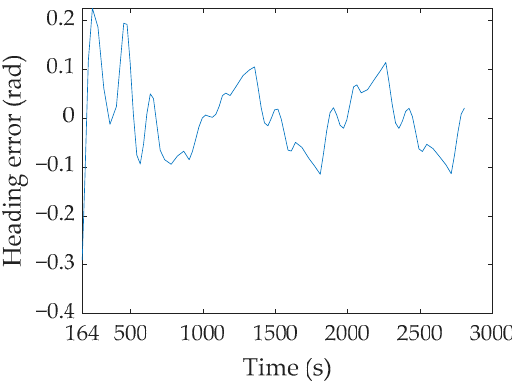
Figure 13. Cross-track heading angle error for the sine curve.